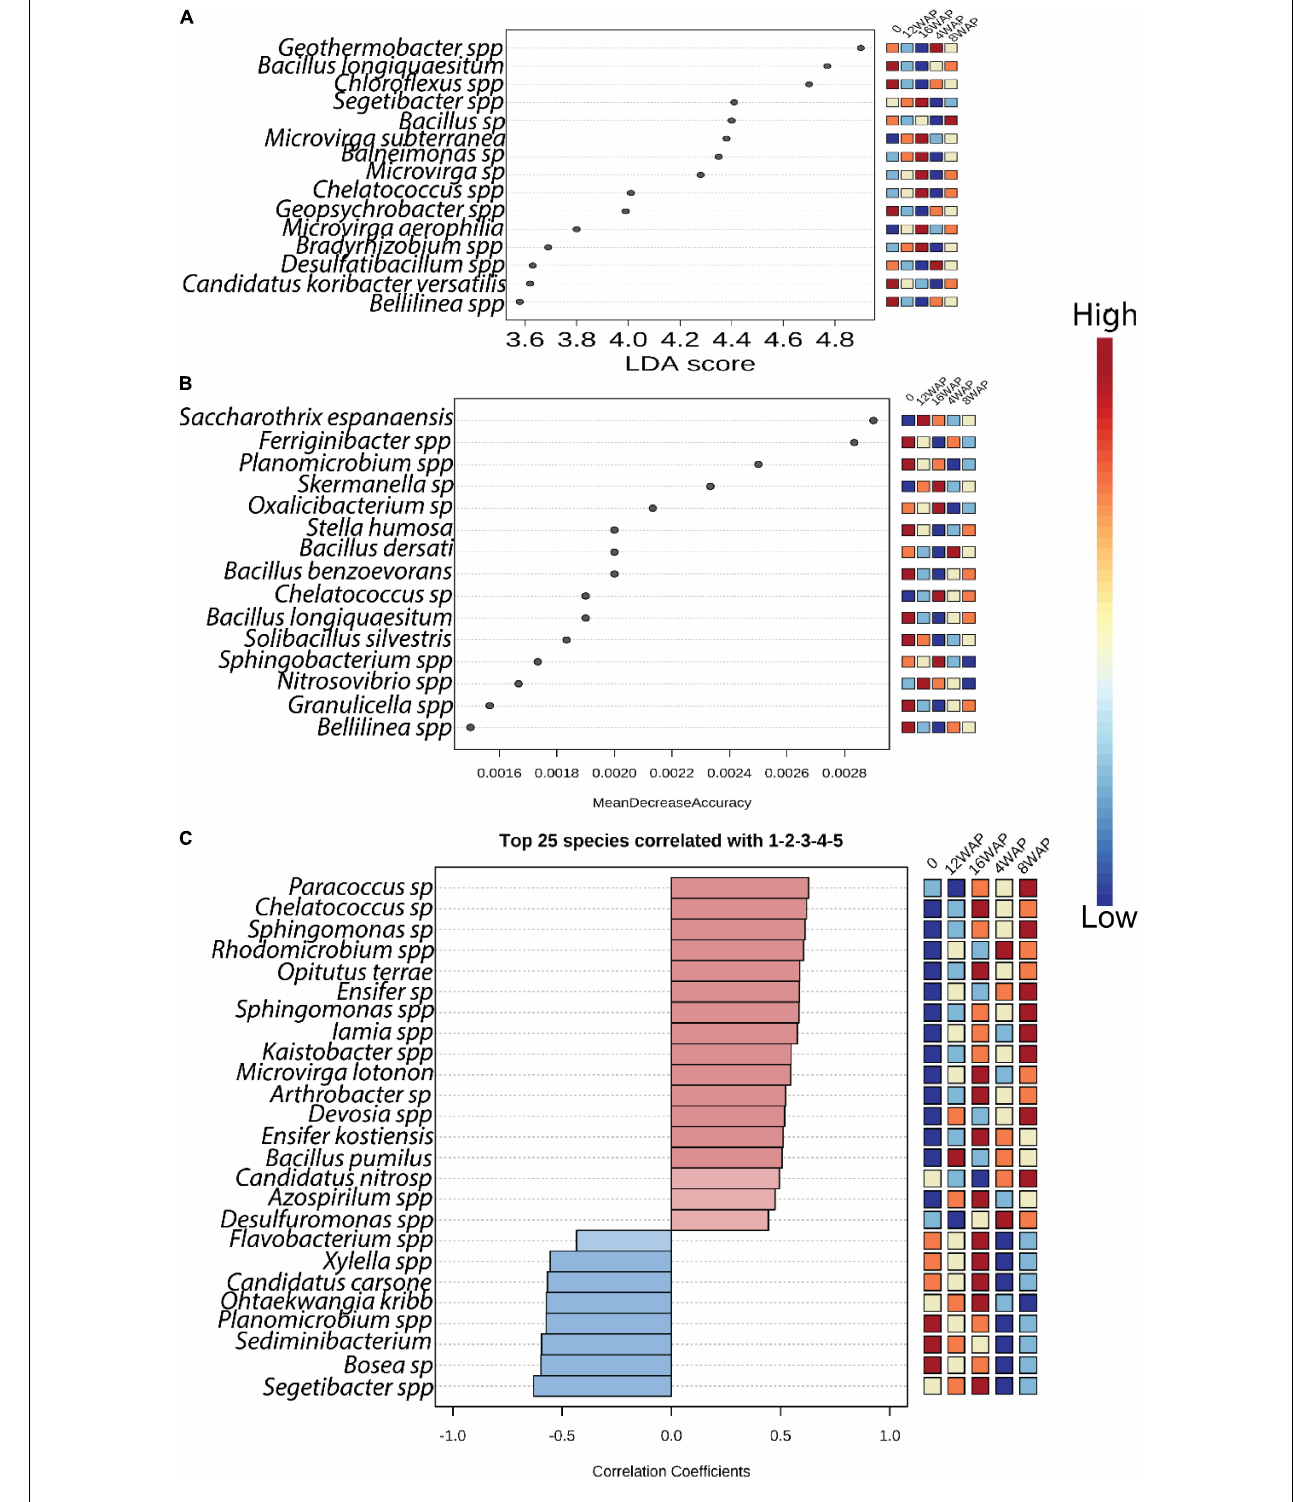
FIGURE 3 | Bacterial biomarkers associated with bulk soil and plant growth stages. (A) LDA analysis indicating the differences in bacterial taxa among the growth stages (B) Random forest analysis indicating the differences in bacterial taxa among the growth stages. (C) Correlation pattern network analysis indicating the differences in bacterial taxa among the growth stages. Only predictors with significant effects are shown. Color from blue to red indicates from low to high level of significance.